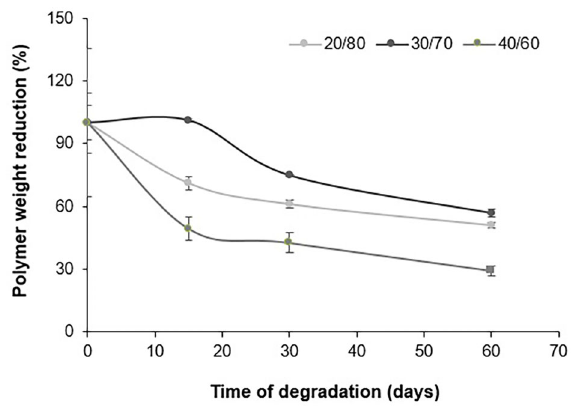
Figure 2. Average molecular weight ( M w ) of electrospun poly (trimethylene carbonate- co -L-lactide) (PTMCLLA) 20/80, 30/70, and 40/60 scaffolds, during the 60-day degradation assay. Data are reported as means ±